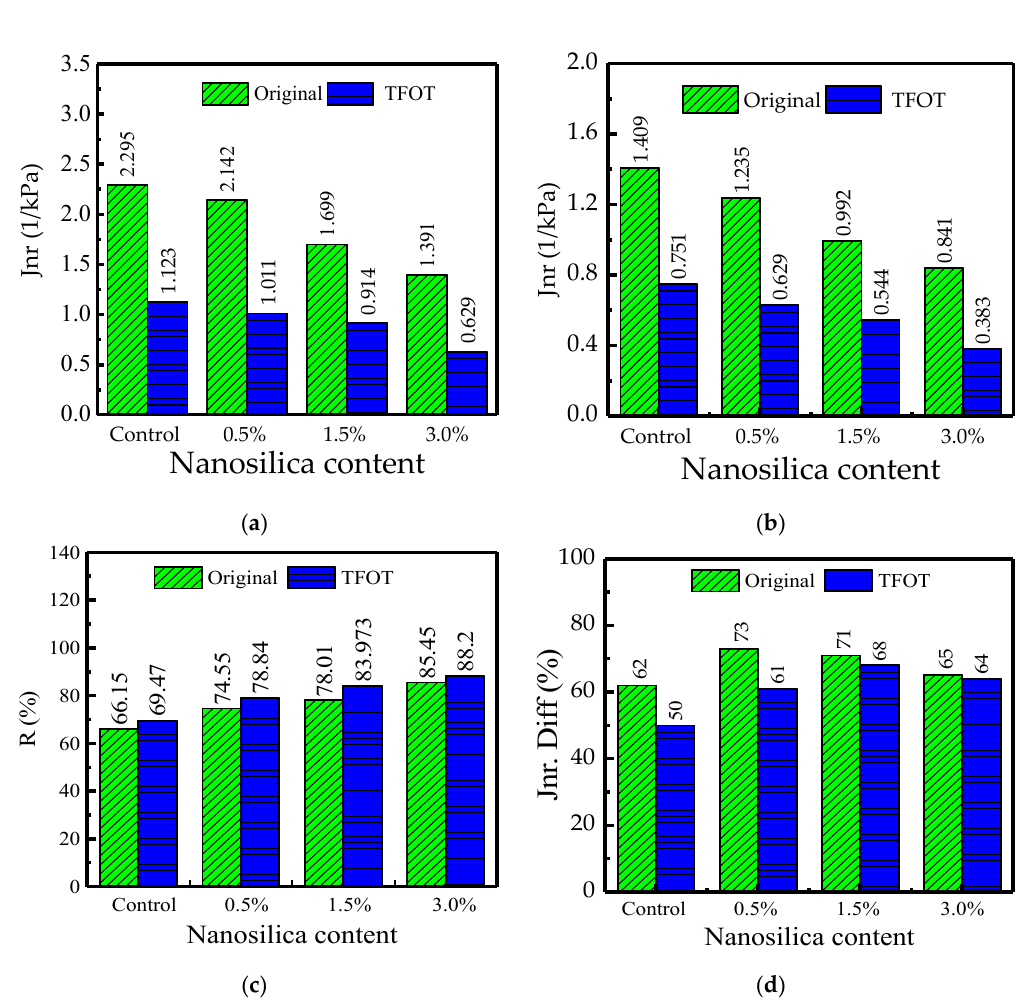
Figure 9. Multiple stress creep recovery (MSCR) of asphalt samples. ( a ) J nr0.1 ; ( b ) J nr3.2 ; ( c ) percentage recoverable; ( d ) J nr Difference.